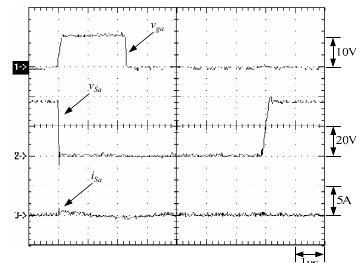
Figure 20. Waveforms pertaining to S 2 at the minimum load: (1) v g 2 ; (2) v S 2 ; and (3) i S 2 .